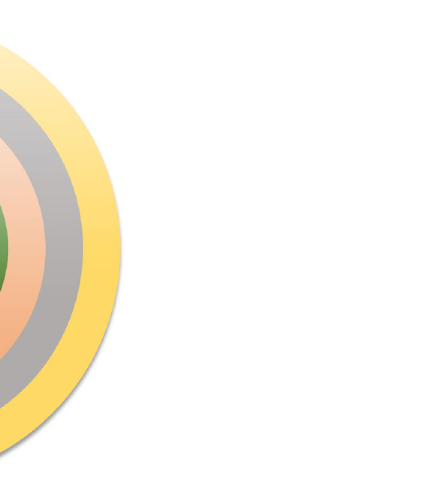
Figure 11. Opportunities for India’s ELV recycling